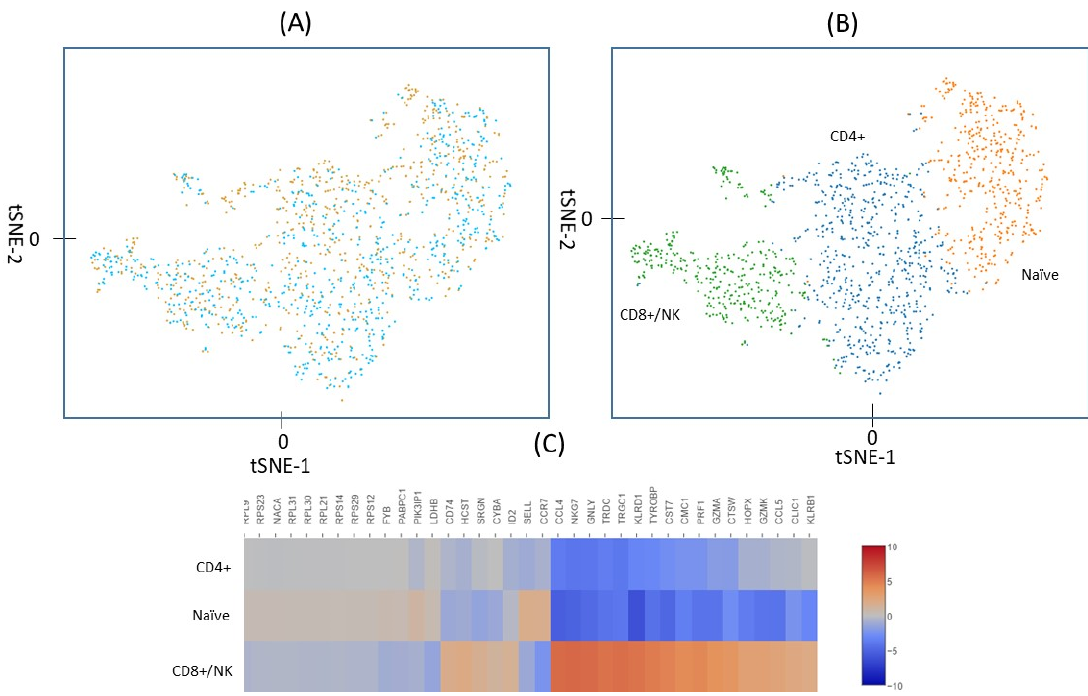
Figure 2. ( A ) Unsupervised t-SNE analysis of the UMI counts in the irradiated (orange) and control (blue) cells. ( B ) A graph-based hierarchical clustering algorithm separated the cells into three groups (clusters), shown as three different colors. ( C ) Heat diagram of gene expression in each of the three clusters. Marker genes identified cluster 1 (blue in B) as CD4+ cells, cluster 2 (orange in B) as naïve cells and cluster 3 (green in B) as CD8+/NK cells. The naïve cells include both naïve CD4+ and naïve CD8+ cells.